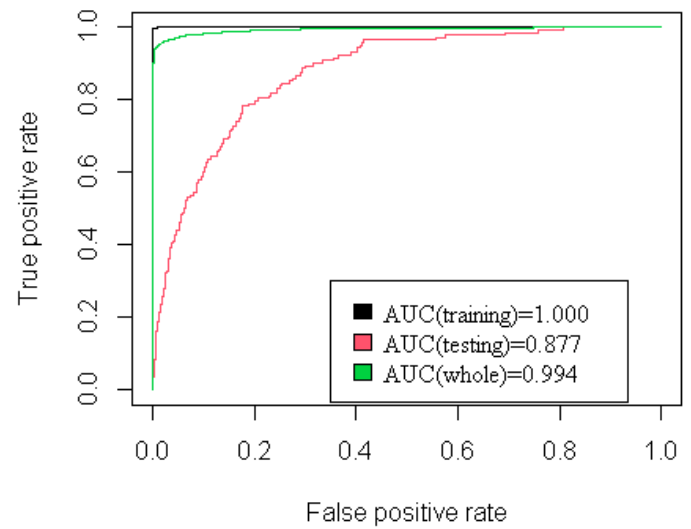
Figure 11. ROC curve and AUC value.